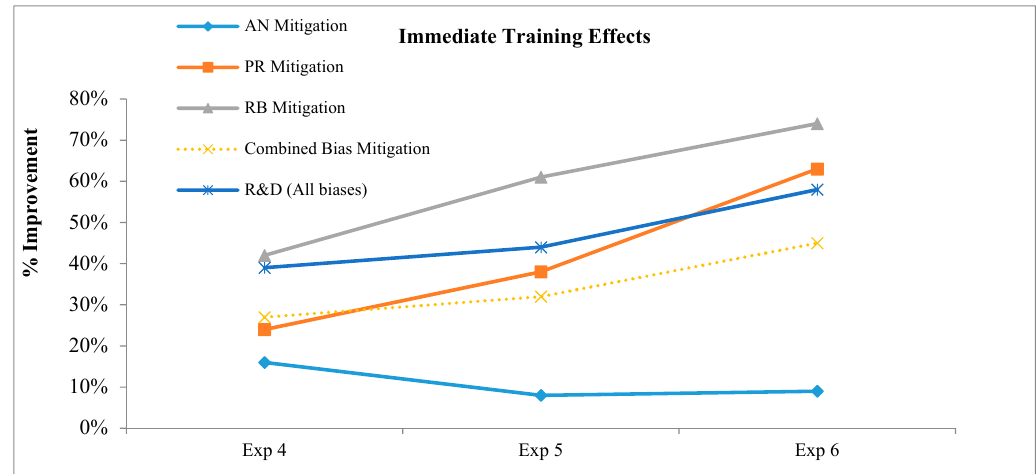
Figure 4. Improvement of bias mitigation by bias for best game per experiment for CYCLES Carnivale . Exp. 4 n = 119; Exp. 5 n = 125; Exp. 6 n = 135. AN mitigation—performance on a measure that elicited anchoring; PR—performance on a measure that elicited projection bias; RB—performance on a measure that elicited representativeness bias; Combined Bias—a composite measure of all three biases; R&D—knowledge-based recognition and discrimination of biases.